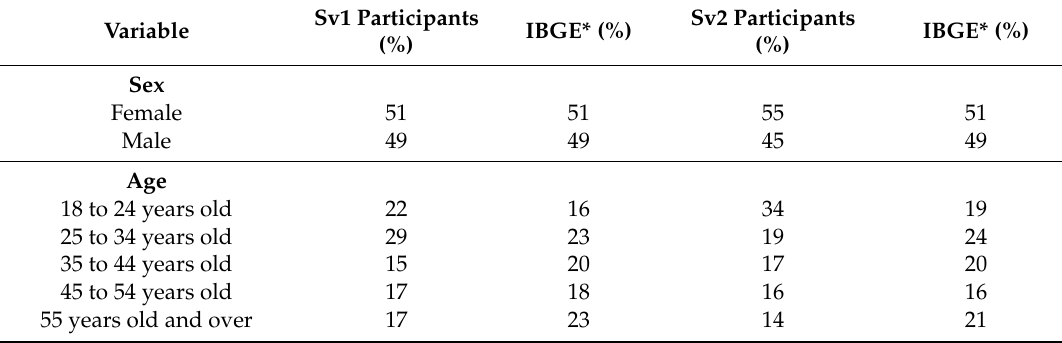
Table A1. Demographics of survey participants (Sv1, n = 441; Sv2, n = 768) and of the